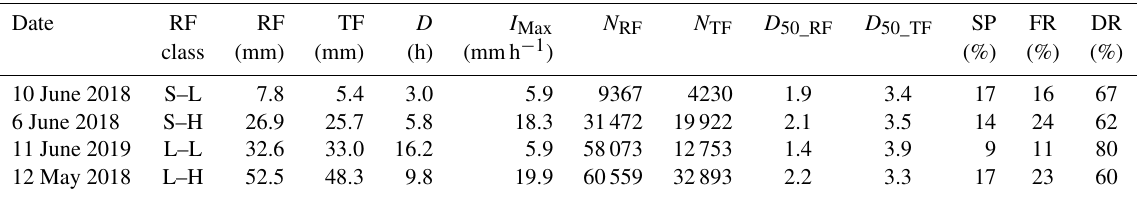
Figure 4. (a) δ 18 O and δ 2 H values of open rainfall and throughfall. The dashed line shows the local meteoric water line (LMWL). (b) The relationship between the deuterium excess (d-excess) of open rainfall and throughfall. Table 2. Measured variables for the four selected events: S–L denotes short duration–low intensity, S–H denotes short duration–high intensity, L–L denotes long duration–low intensity and L–H denotes long duration–high intensity. RF is rainfall, TF is throughfall, D is rainfall duration, I Max is the maximum 30min rainfall intensity, N is the number of drops, D 50 is the median volume drop diameter, SP is splash throughfall, FR is free throughfall and DR is canopy